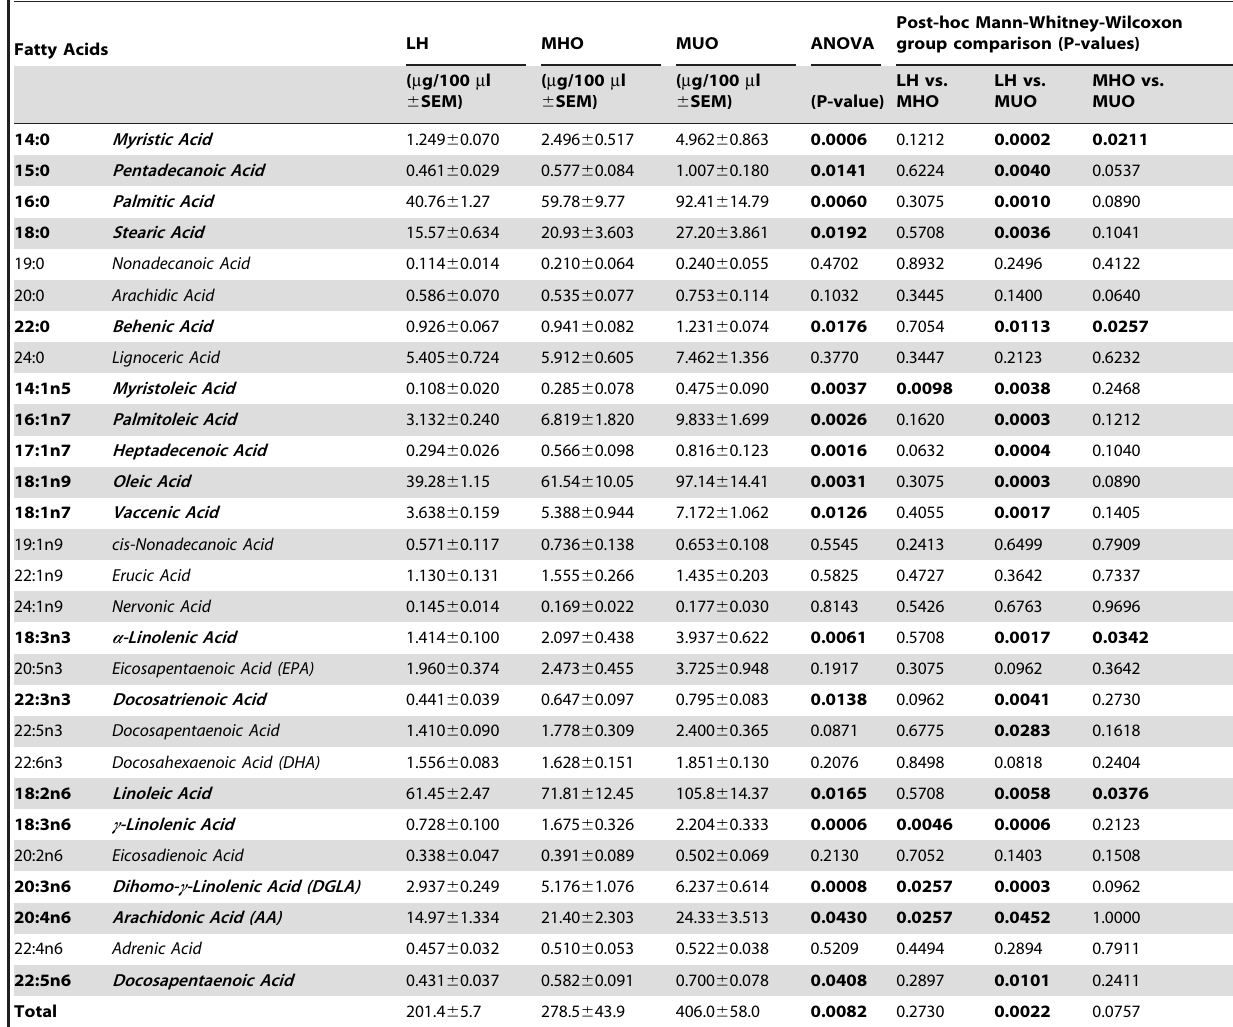
Table 4. Mean absolute values of total fatty acids in